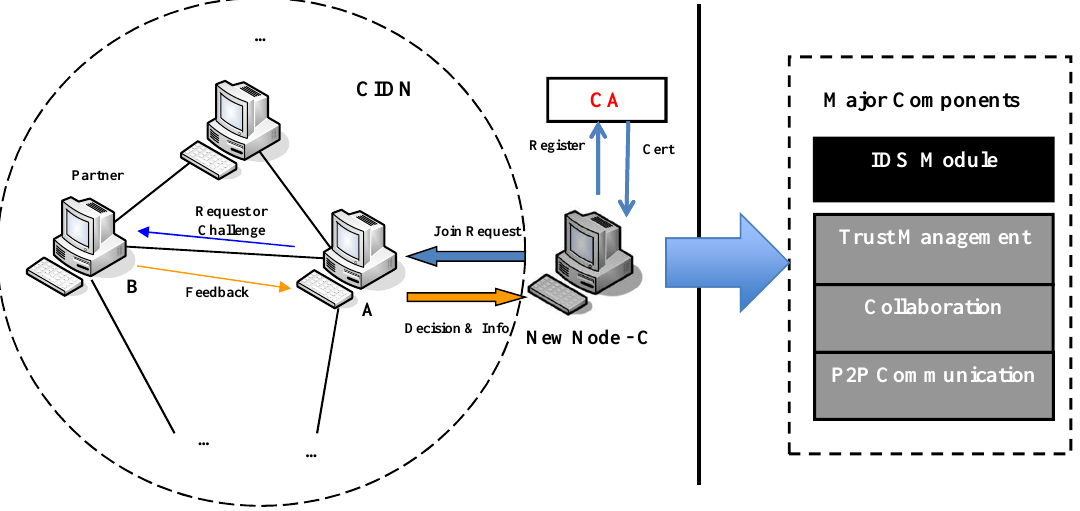
Figure 1. The high-level architecture of a typical challenge-based collaborative intrusion detection network